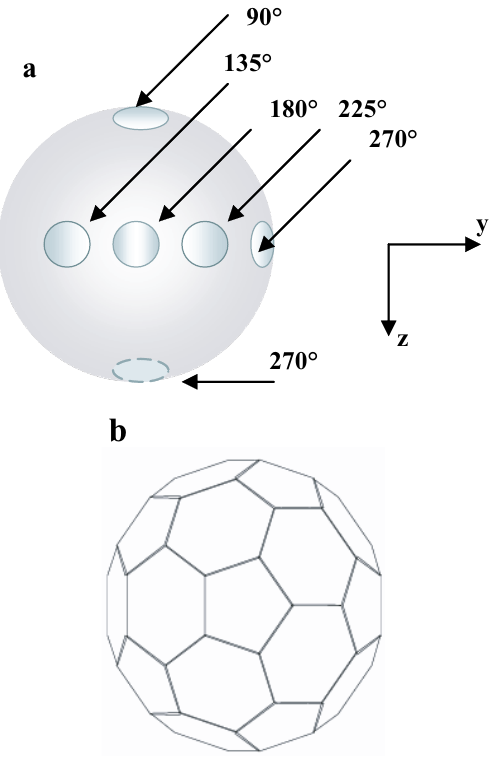
Fig. 1. ( a ) SLP configuration with 6 independent collectors. The symmetry axis of the central collector is aligned with the satel- lite velocity (along x) and facing the ram. ( b ) Representation of the sphere in the model by an assembly of 12 pentagons and 20